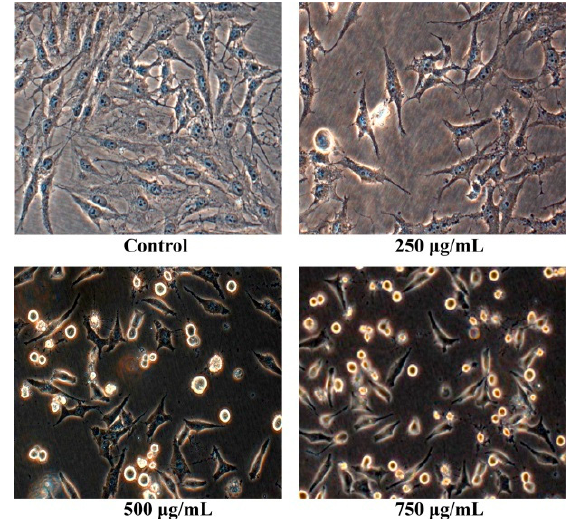
Figure 2. Pien Tze Huang (PZH) reduced cell viability of MG-63 cells. Cells viability treated with serial concentrations of PZH (250, 500 and 750 μ g/mL) for 24 h was determined. Data are expressed as mean ± SD for three independent experiments.